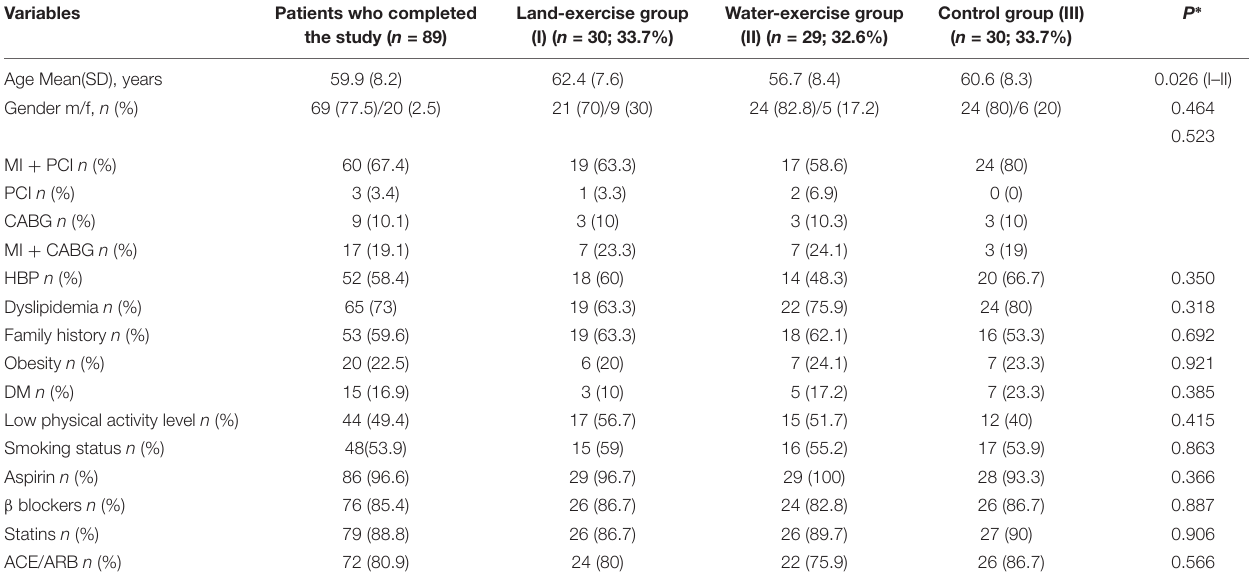
TABLE 1 | Baseline characteristic of the patients who completed the study. Variables Patients who completed